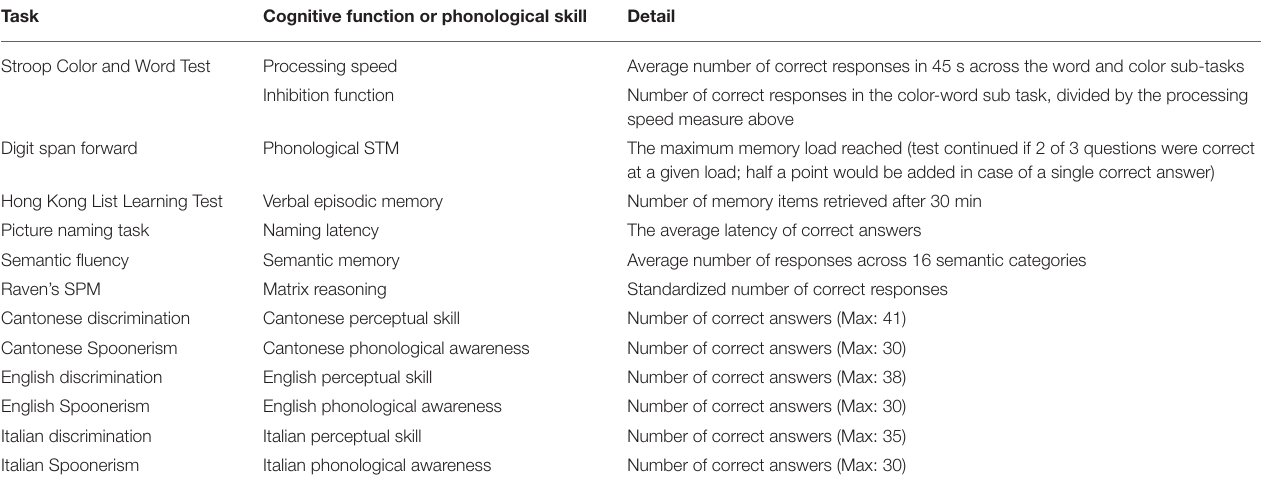
TABLE 1 | Measures of behavioral test